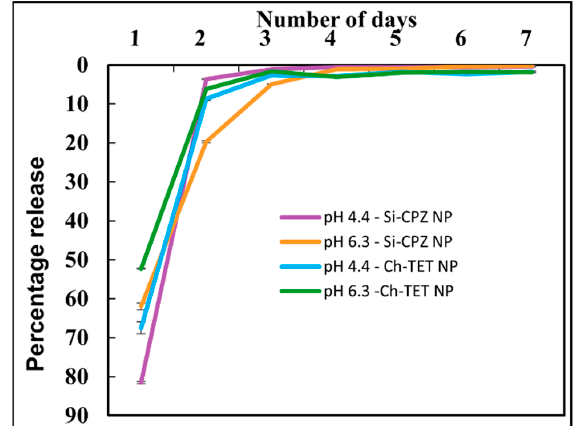
Figure 3. Release kinetics of drugs from nanoparticles. Release kinetics of tetracycline ( λ = 285 nm) and chlorpromazine ( λ = 305 nm) from chitosan nanoparticles and silica nanoparticles were measured, respectively, using a spectrophotometer.